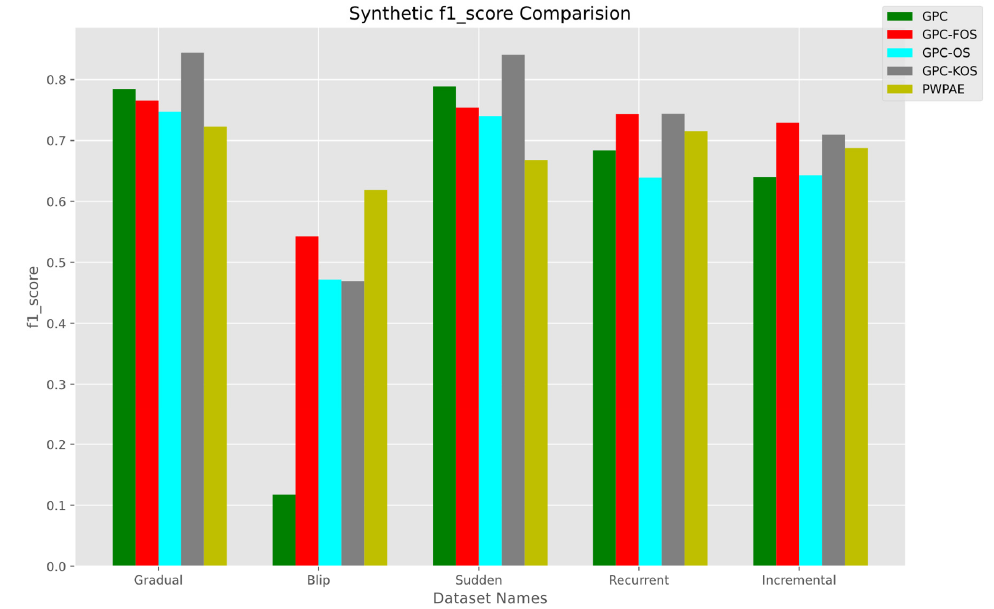
Figure 6. F1-score of the incremental GPC (OS, FOS, KOS) variants and benchmarks (GPC, PWPAE) for synthetic data.